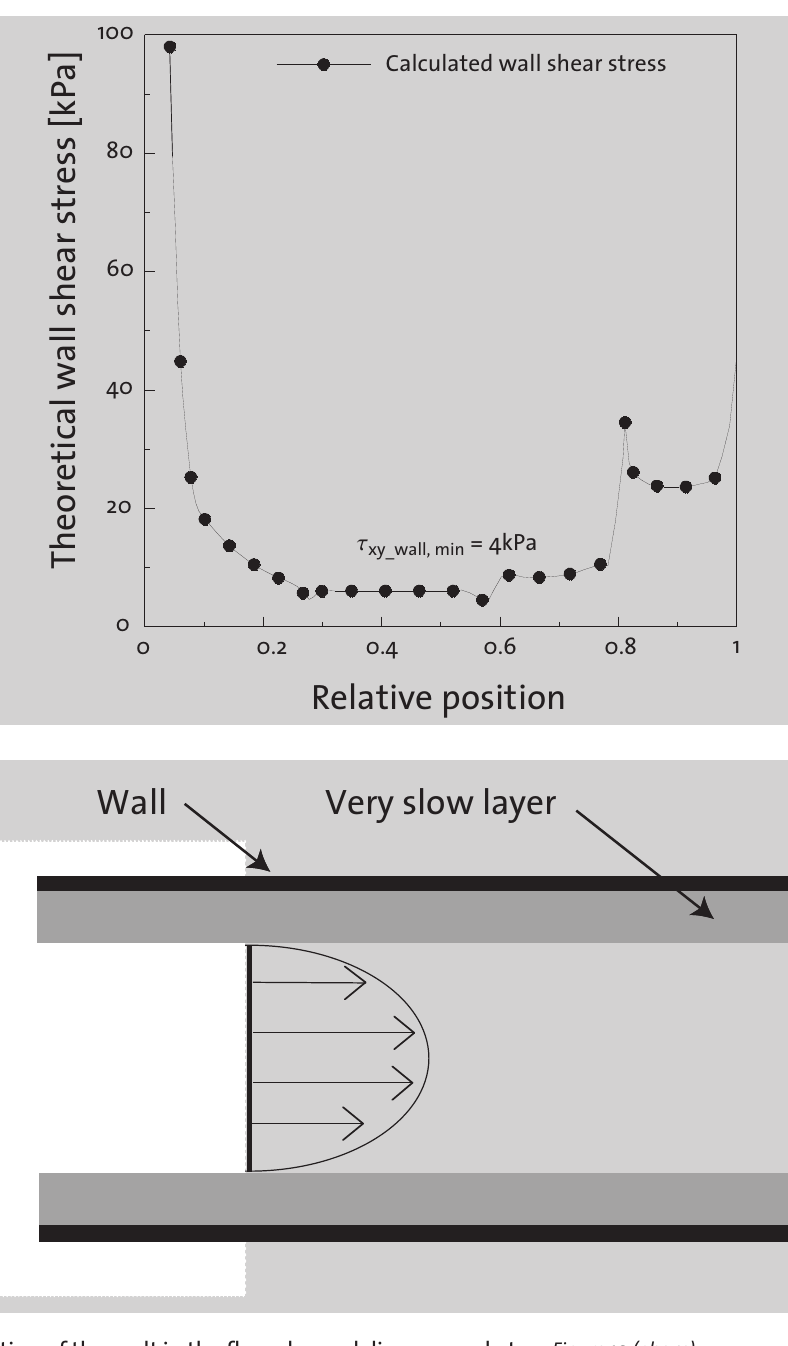
Figure 10 (above): Channeling. Material only uses as much of the channel as necessary.